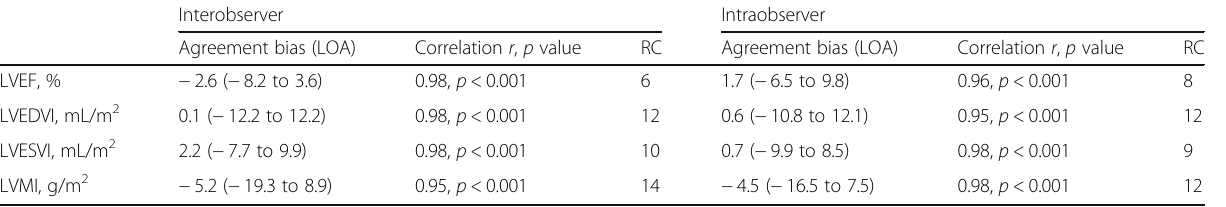
Table 4 Interobserver and intraobserver reproducibility of accelerated k-t SENSE